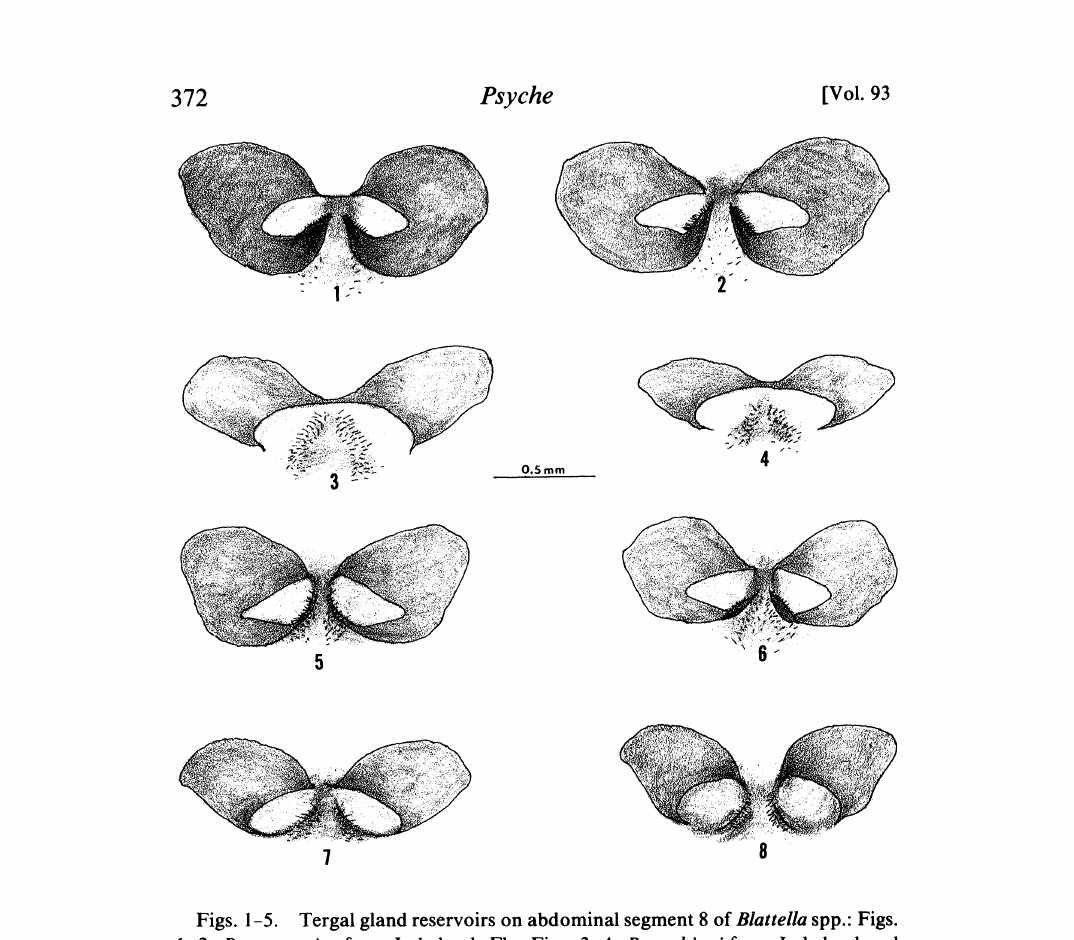
Figs. 1-5. Tergal gland reservoirs on abdominal segment 8 of Blattella spp.: Figs. 1, 2. B. germanica from Lakeland, Fla. Figs. 3, 4. B. asahinai from Lakeland and Okinawa, respectively. Figs. 5-8. F males resulting from a cross between male asahinai and female